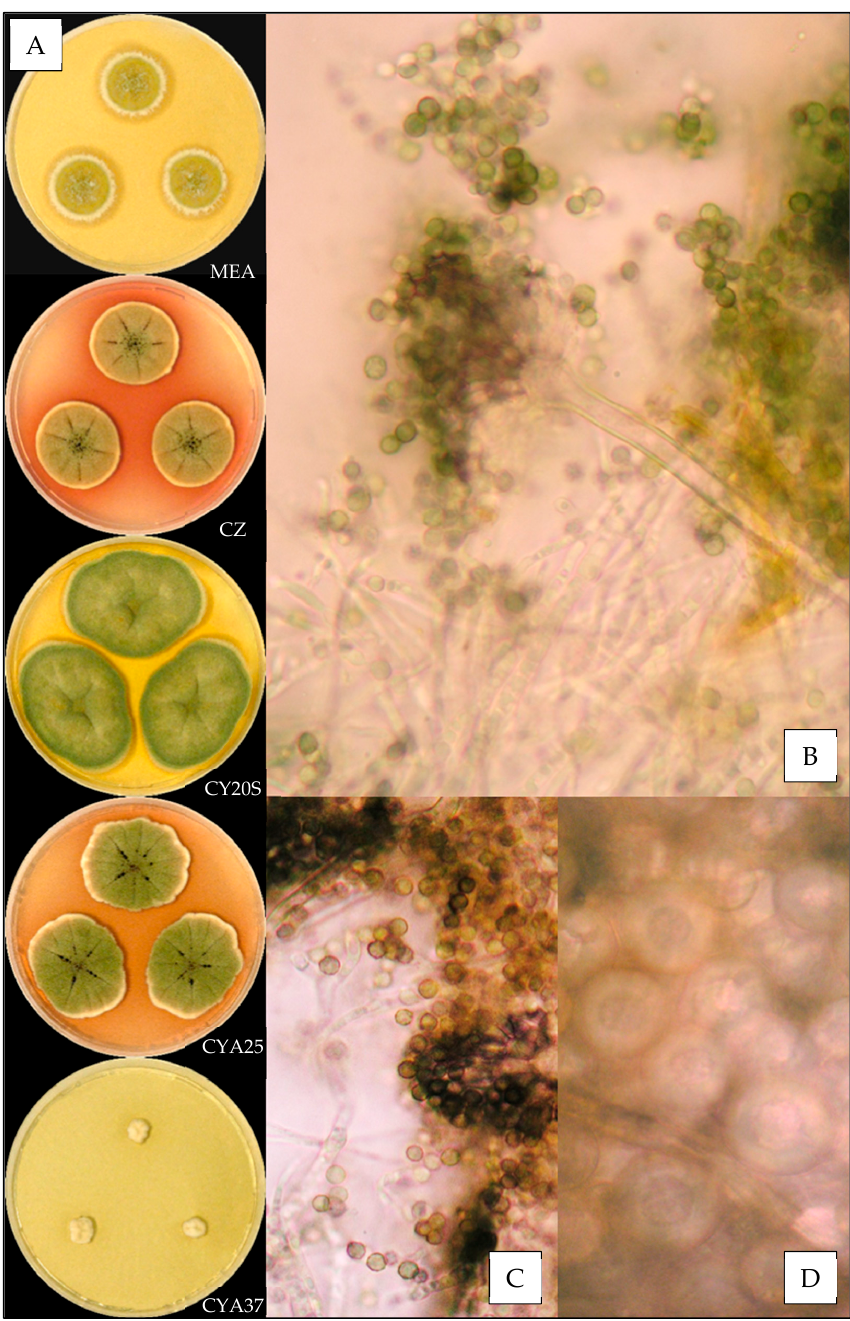
Figure 9. Aspergillus tabacinus : ( A ) from top to bottom, colonies on MEA, CZ, CY20S, CYA25 and CYA37, 14 days. ( B ) Conidial head, ( C ) conidia and ( D ) globose Hülle cells (1000×).